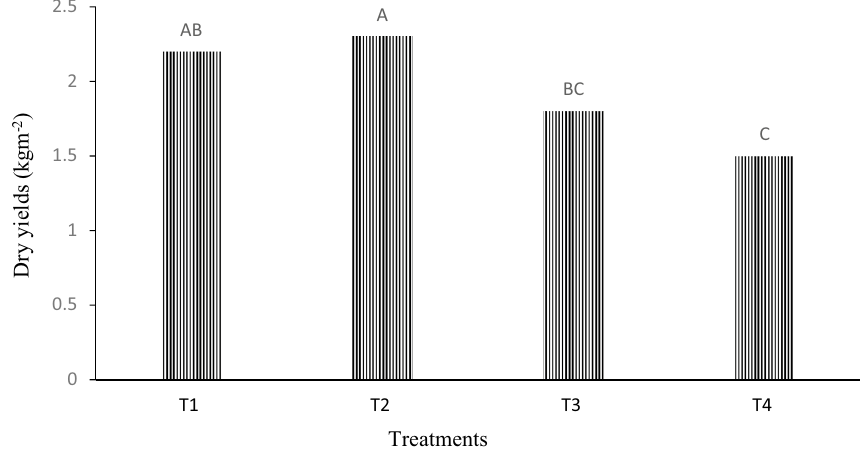
Figure 2. Dry yields in different seeding distance. Bars with different letters were significantly (p < 0.05) different from each